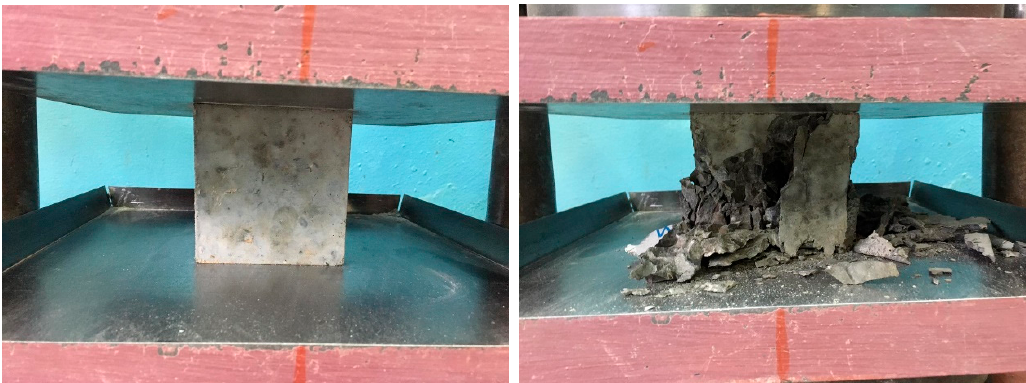
Figure 6. Compressive strength test of cubes of basic composition. The results of experimental studies of the effect of a combination of various types of fibers and volume content on the strength and deformation characteristics of fiber- reinforced concrete are presented in Table 8 and Figures 7–11. Table 8. Results of experimental studies of the effect of a combination of various types of fibers and volume content on the strength and deformation characteristics of fiber-reinforced concrete.